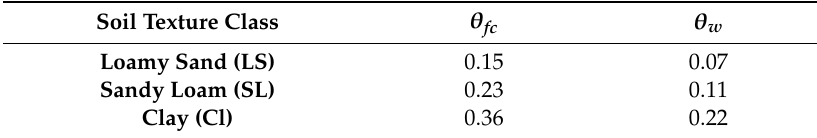
Table 4. Soil moisture at field capacity ( θ fc ) and wilting point ( θ w ) for texture classes at 2.5%w organic matter (OM), no salinity, gravel or density adjustment (values after